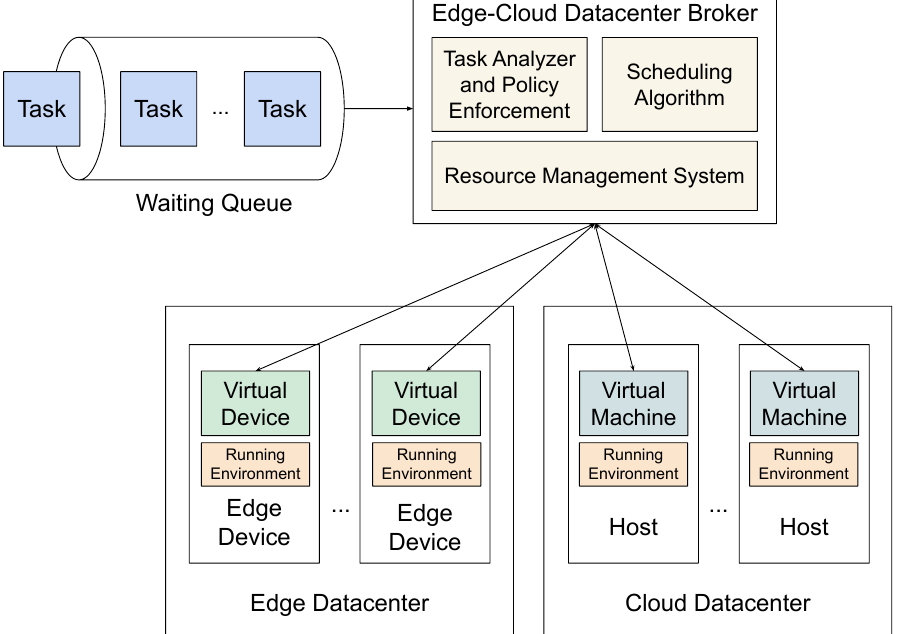
Figure 1. Scheduling in an edge–cloud collaborative computing